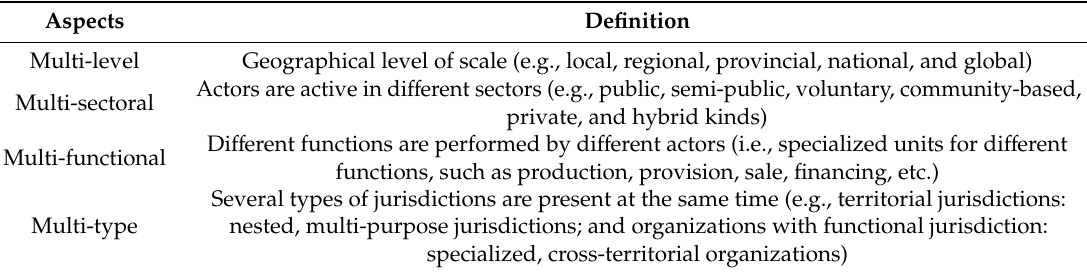
Table 1. Aspects of polycentric constellations based on [26,27].